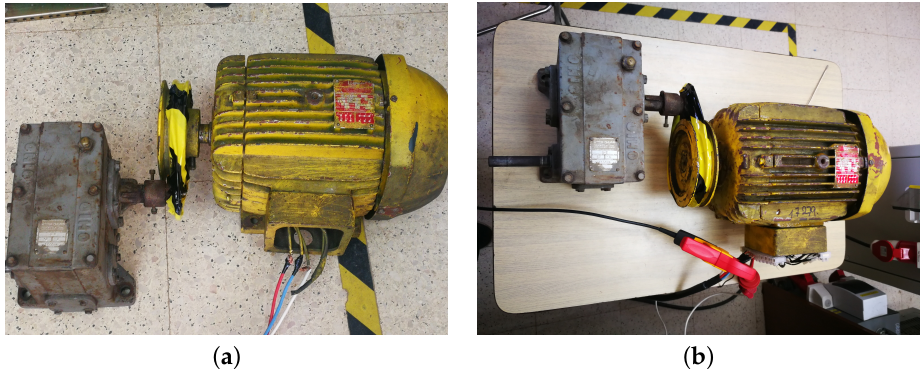
Figure 11. Experimental setup for locked rotor test. ( a ) Three-phase IM. ( b ) Nine-phase